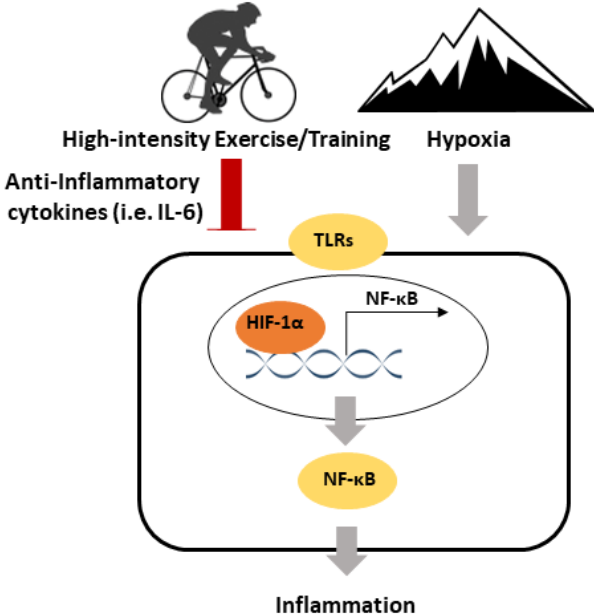
Figure 2. A speculative model for the inflammatory responses to high-intensity exercise/training and hypoxia. Exercise/Training exhibits anti-inflammatory effects via the induction of anti-inflammatory cytokines and downregulating toll-like receptor (TLR) signalling. Hypoxia is pro-inflammatory and mediates the upregulation of TLR signalling. HIF-1α is important in regulating the inflammatory response to high-intensity exercise/training and hypoxia.